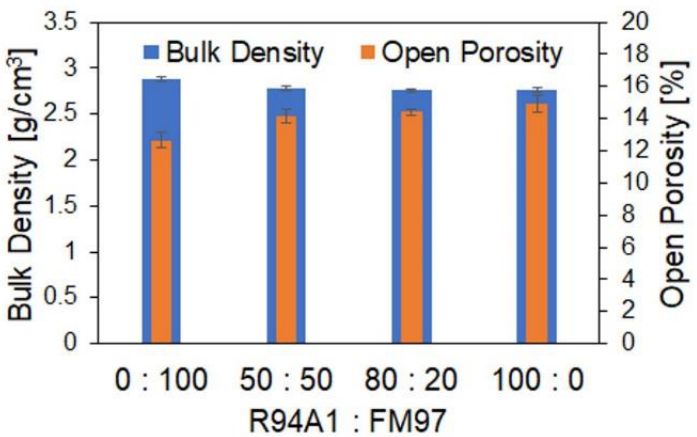
Figure 6. Bulk density and open porosity of coked MgO-C specimens depending on the used weight ratio of recyclate R94A1 to fused magnesia FM97.